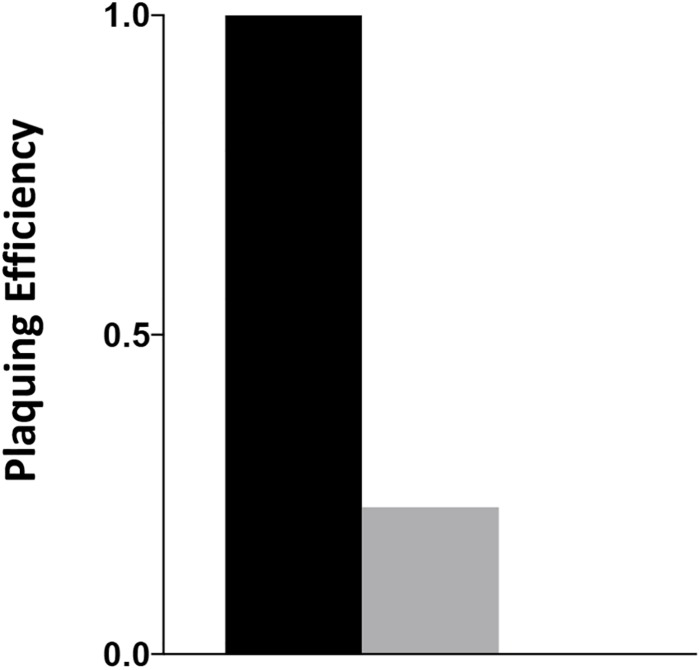
cjridA mutants support reduced plaque formation of phage NCTC 12673. A phage lysate was titered on C. jejuni wild type (black), a cjridA mutant (gray) and pseC mutant (plaquing efficiency of zero). Serial dilutions of the lysate were spotted on a NZCYM 0.6% agar overlay seeded with the appropriate bacterial mutant. After 1 day, plaque forming units (PFU/mL lysate) were determined with three technical triplicates of wild type, and two biological replicates in technical duplicate for the cjridA mutant. Number of plaques on wild type was defined as an efficiency of 1.